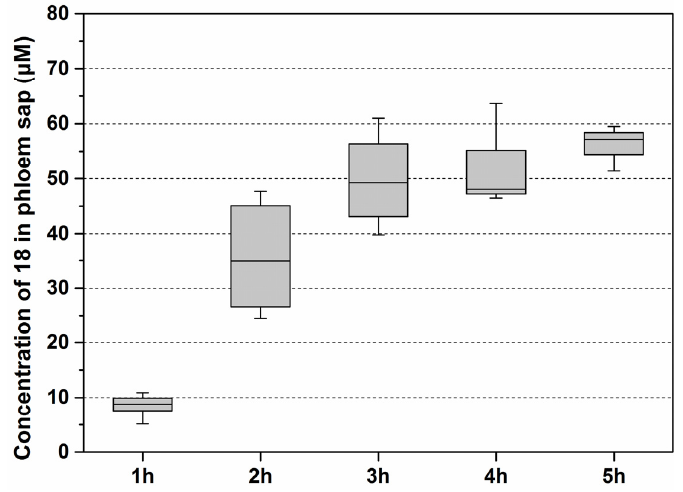
Figure 4. Time course of conjugate 18 concentration in phloem sap of R. communis. The cotyledons were incubated in a buffered solution containing 200 µ M 18 at pH 5.5. The hook was severed at time 1 h, and then the sap was collected every 1 h during 5 h. For box plots, n = 8.